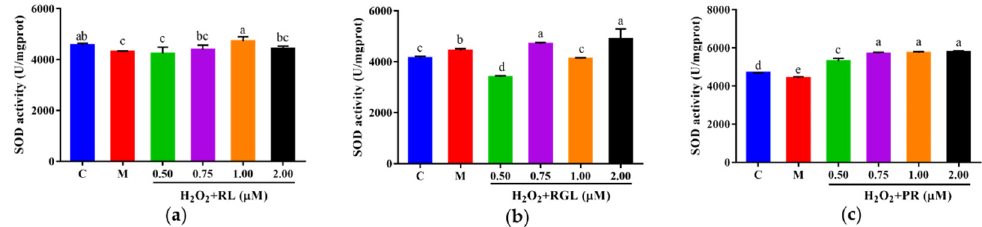
Figure 14. SOD activity of HepG2 cells with oxidative stress treated with synthetic peptides: ( a ) synthetic peptide RL; ( b ) synthetic peptide RGL; ( c ) synthetic peptide PR. “C” represents the control group, and “M” represents the model group. Data were expressed as mean ± SD ( n ≥ 3, p < 0.05). Different letters indicate significant differences ( p < 0.05).